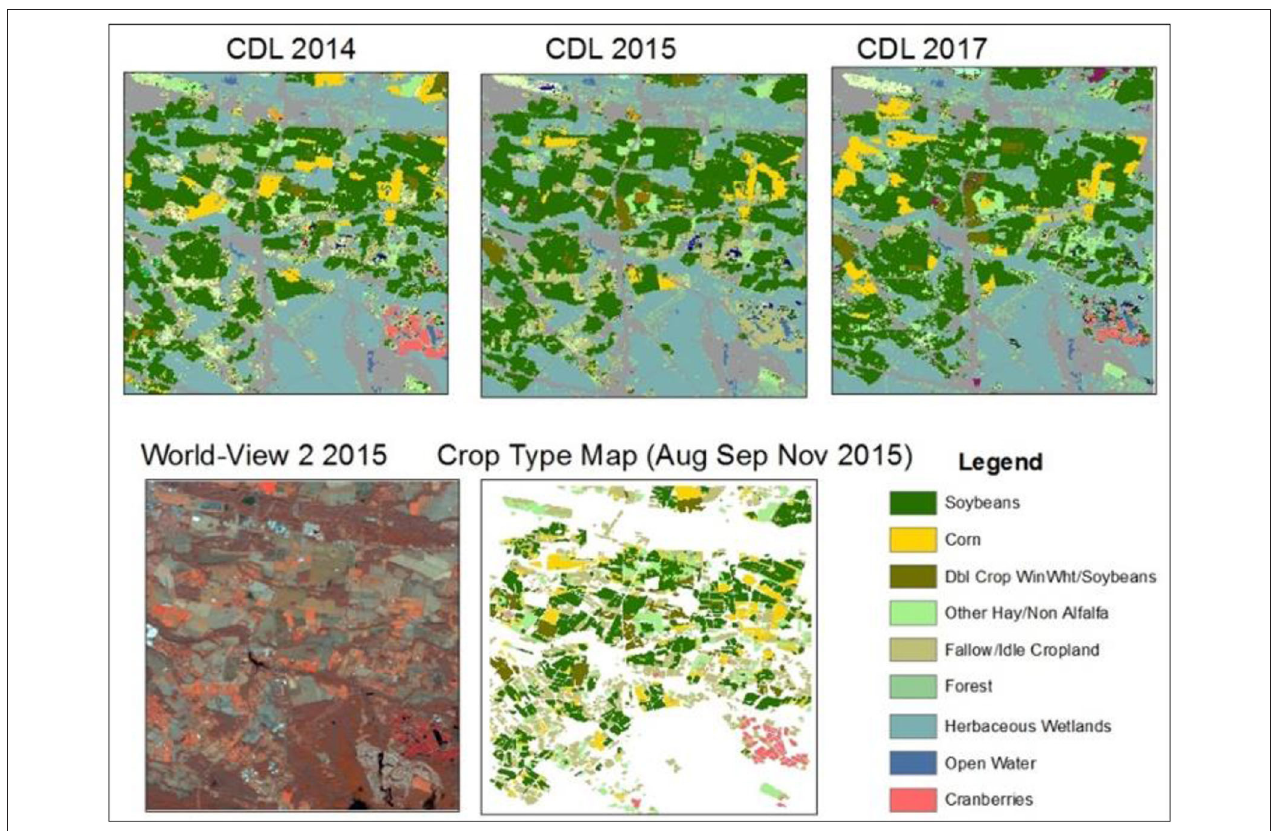
FIGURE 10 | The comparison of CDL reference data of the small field size TR region with the satellite